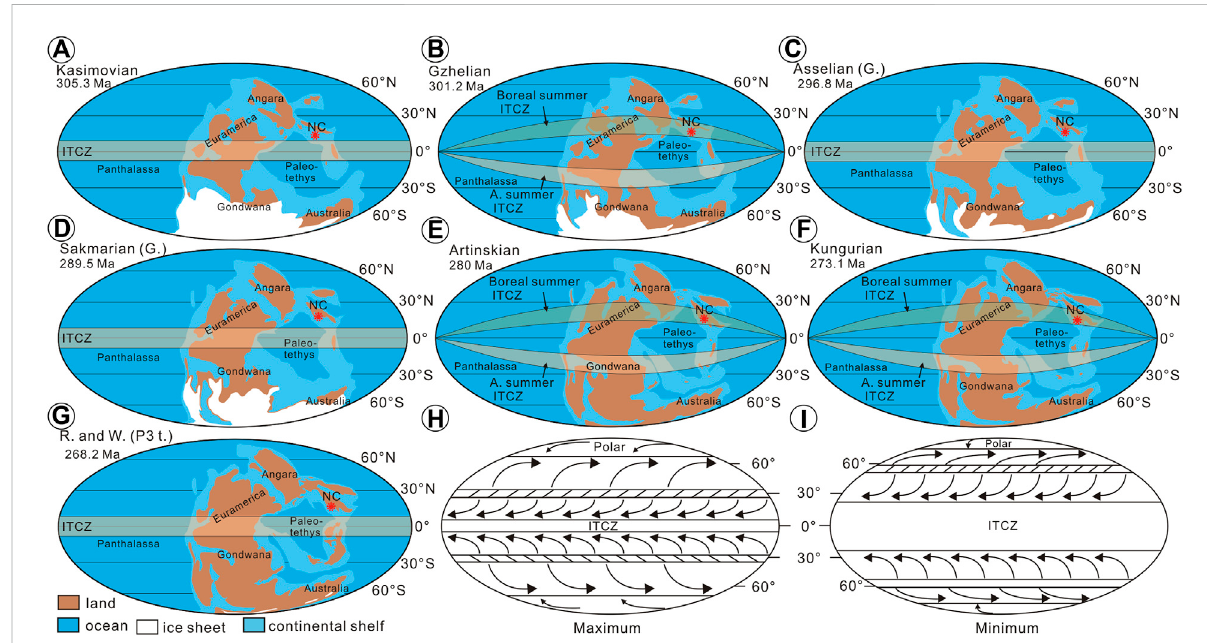
FIGURE 9 Global paleogeographic maps from the Kasimovian stage of the Carboniferous to the Wordian stage of the Permian (A – G) superimposed by Hadley circulation patterns for glacial maximum (H) and glacial minimum (I) conditions [modi fi ed from Tabor and Poulsen (2008)]. Base maps modi fi ed from Scotese and Wright (2018) (http://www.earthbyte.org/paleodem-resourcescotese-and-wright-2018/). Abbreviations: G. = Glaciation; R. and W. (P3 t.) = Roadian and Wordian (Glacier P3 transition); NC = North China; ITCZ = Intertropical Convergence